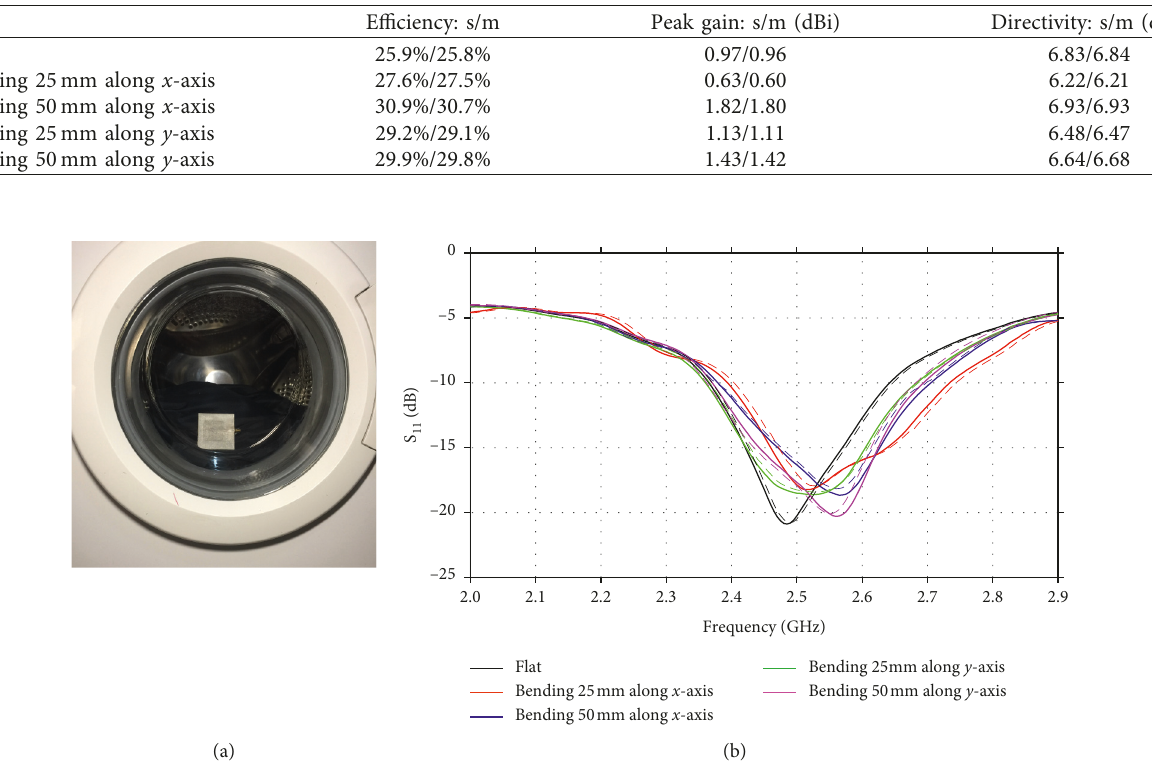
Table 1: Simulated and measured efficiency, peak gain, and directivity in all